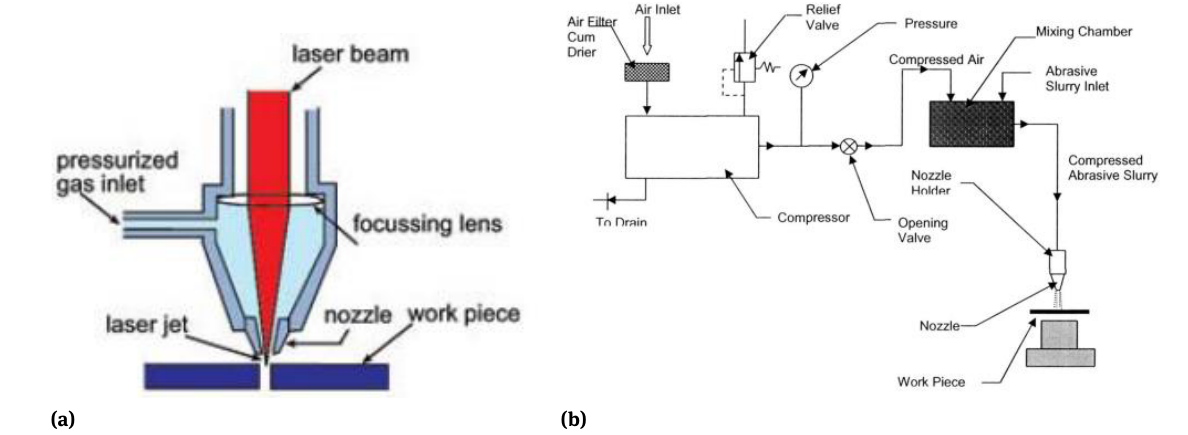
Figure 1: Diagrammatic representation of (a) Laser cutting process (b) AWJ